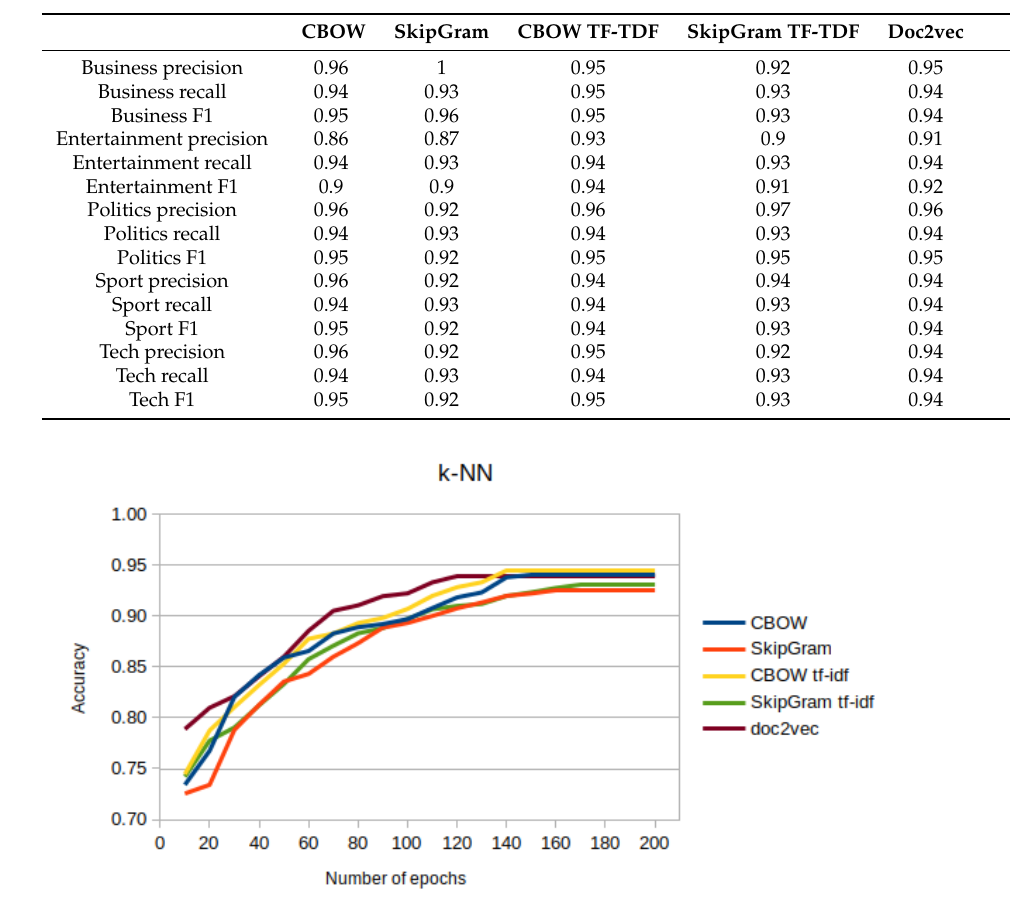
Table 3. Precision, recall, and F1 scores for all vectorization methods with k-NN classification by specific topics.